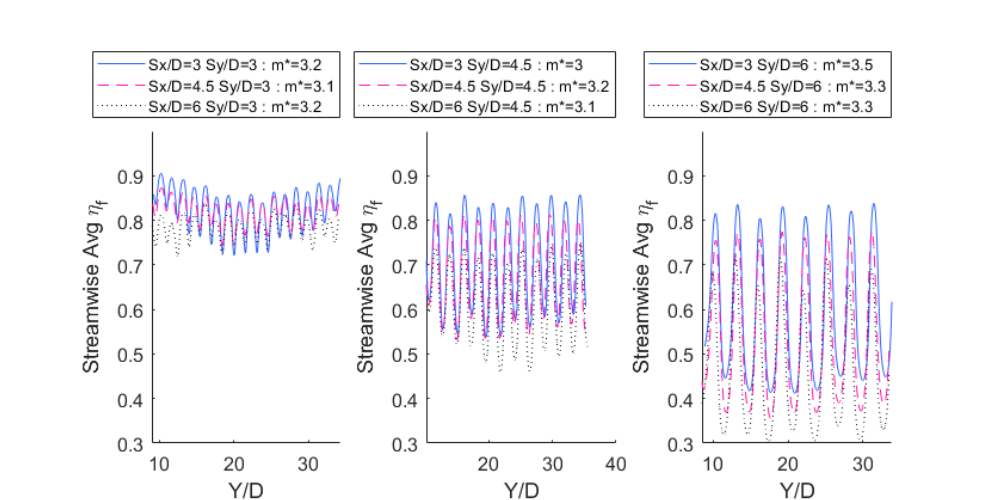
Figure 14. Streamwise-average film effectiveness for m ∗ ≈ 3.2. In each individual plot, geometries with constant S y are shown.